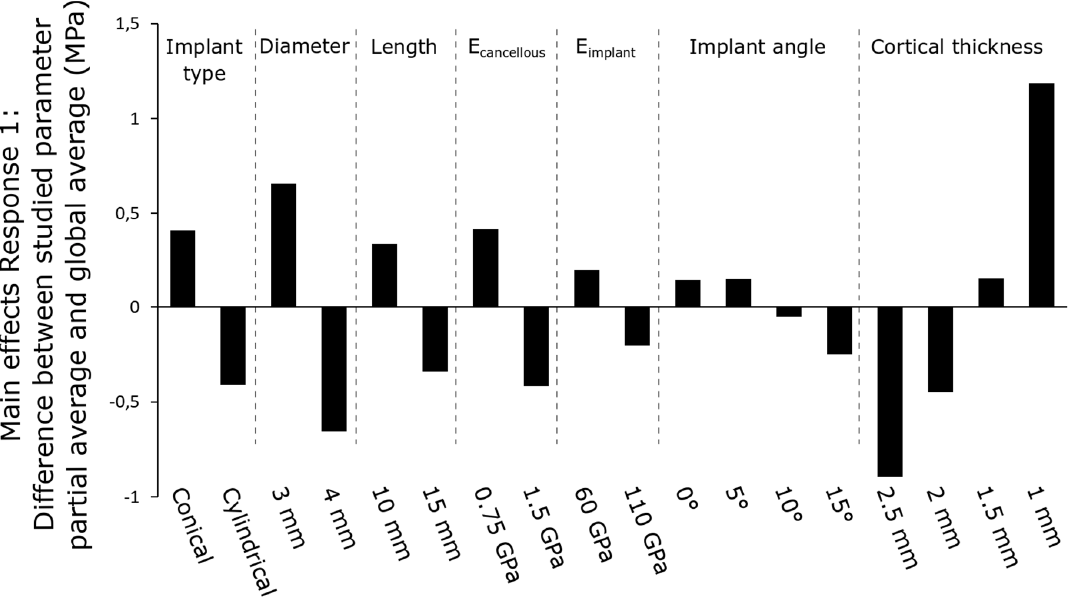
Figure 3. Main effects of parameters on Response 1 (average stress in the peri-implant cortical bone). Appl. Sci. 2020 , 10 , x FOR PEER REVIEW